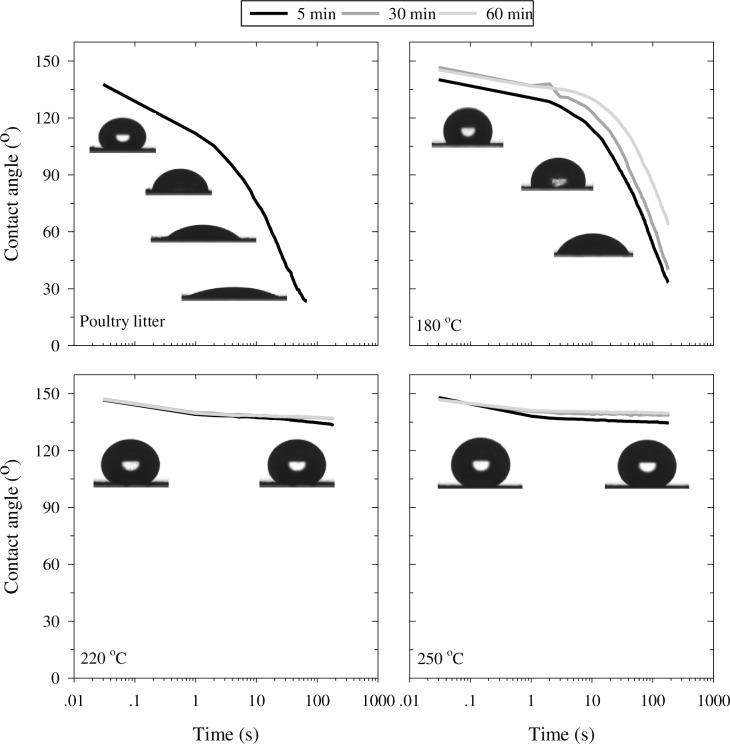
Contact angle of water drop formed on the surface of poultry litter and derived hydrochar.Data for hydrochar generated at 180°C, 220°C, and 250°C at 5, 30 and 60 min is shown. Standard errors were less than 2% for all curves, except for poultry litter and hydrochar produced at 180°C after 5 and 30 min, where it was up to 13%. Photos demonstrate drops created on samples after 60 min of carbonization.